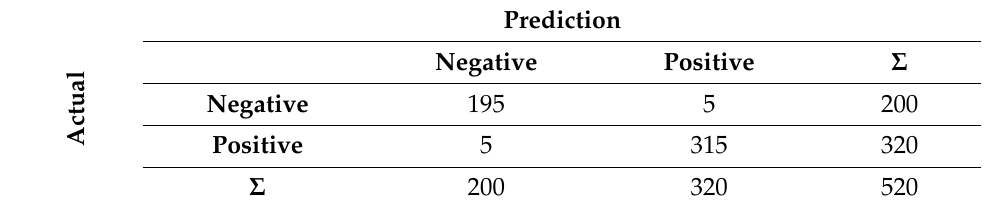
Table 4. Confusion Matrix of Neural Network Classification.